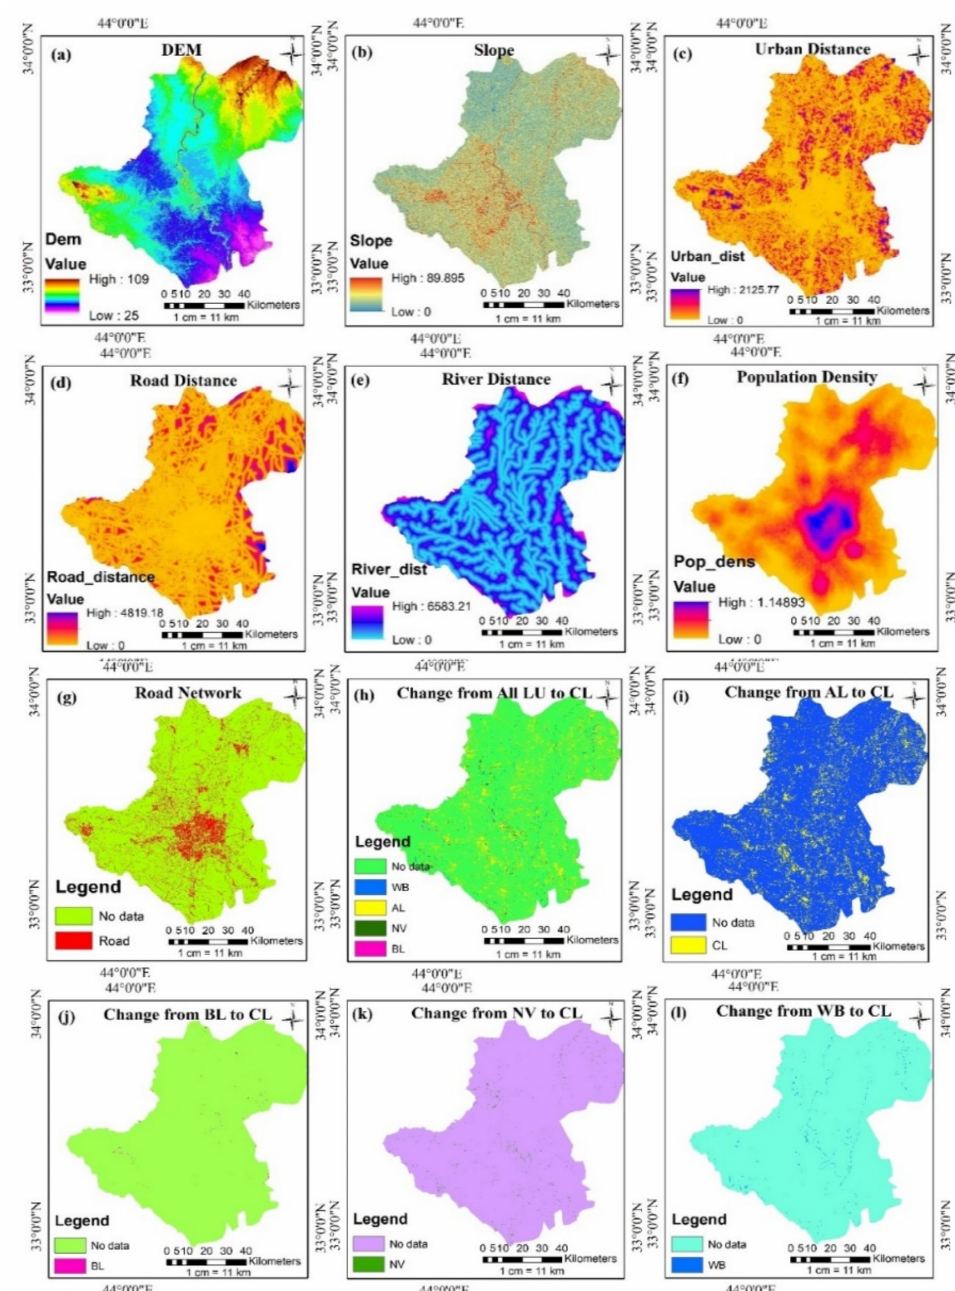
Figure A1. Driver factors for MCM, which include dependent and independent variables. ( a ) DEM; ( b ) slope; ( c ) distance from urban; ( d ) road network; ( e ) distance from road; ( e ) distance from river; ( f ) population density; ( g ) road network; ( h ) all land use change to CL; ( i ) change from AL to CL; ( j ) change from BL to CL; ( k ) change from NV to CL; and ( l ) change from WB to